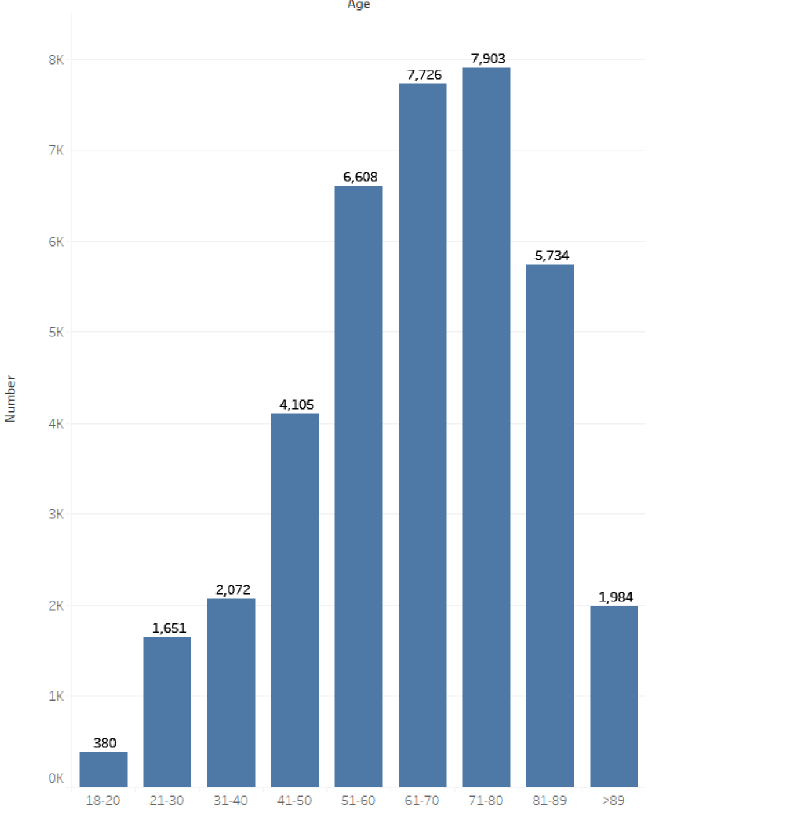
Fig 5. Age distribution of all admitted patients (Total number of patients is 38163).